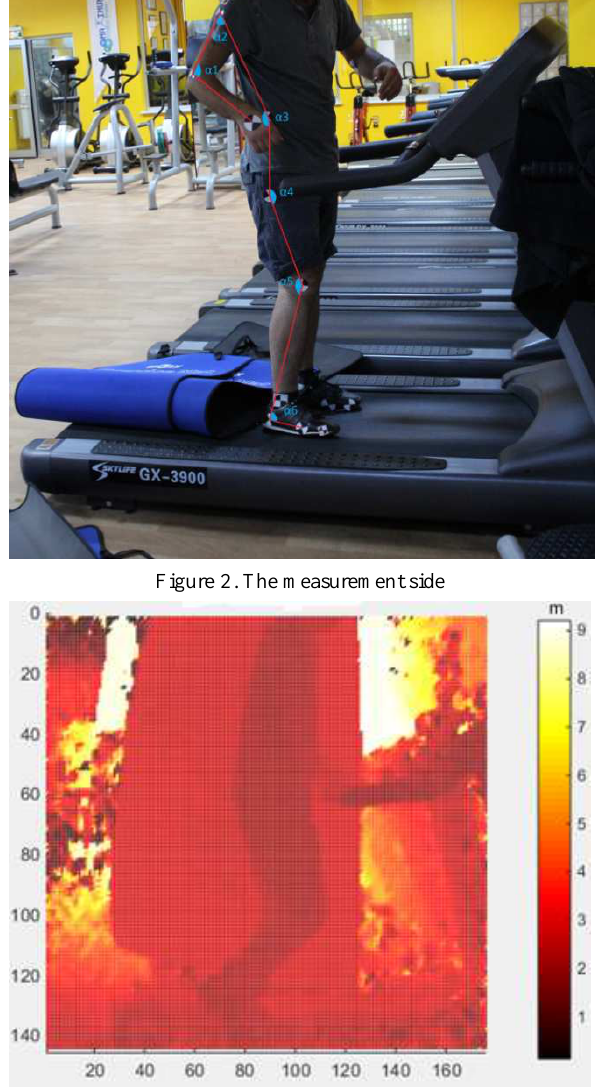
Table 1. Some specifications of used SR4000 camera (url-1)